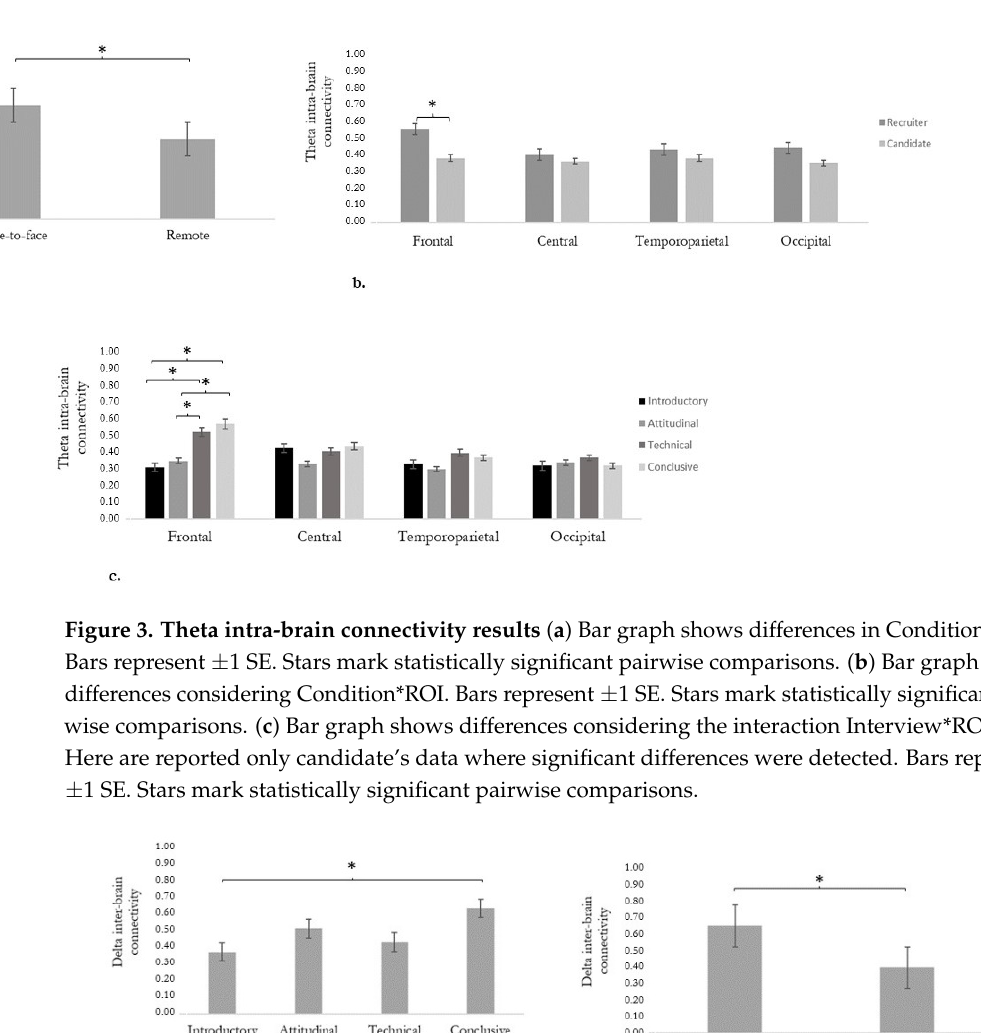
Figure 4. Delta inter-brain connectivity results. ( a ) Bar graph shows differences considering the factor Interview. Bars represent ± 1 SE. Stars mark statistically significant pairwise comparisons. ( b ) Bar graph shows differences considering the Condition factor. Bars represent ± 1 SE. Stars mark statistically significant pairwise comparisons.